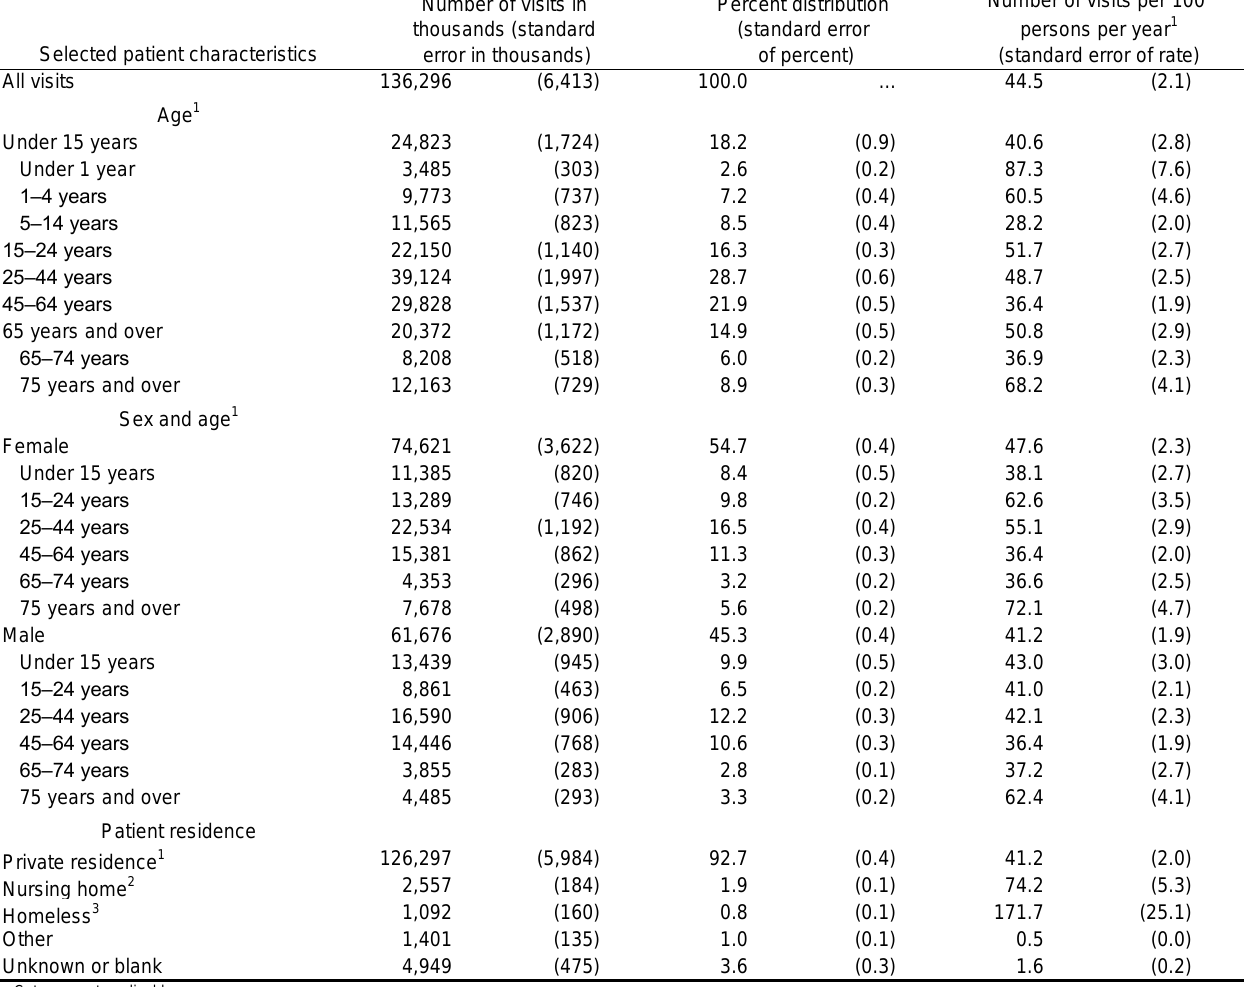
Table 2. Emergency department visits by patient age, sex, and residence: United States, 2011 Number of visits